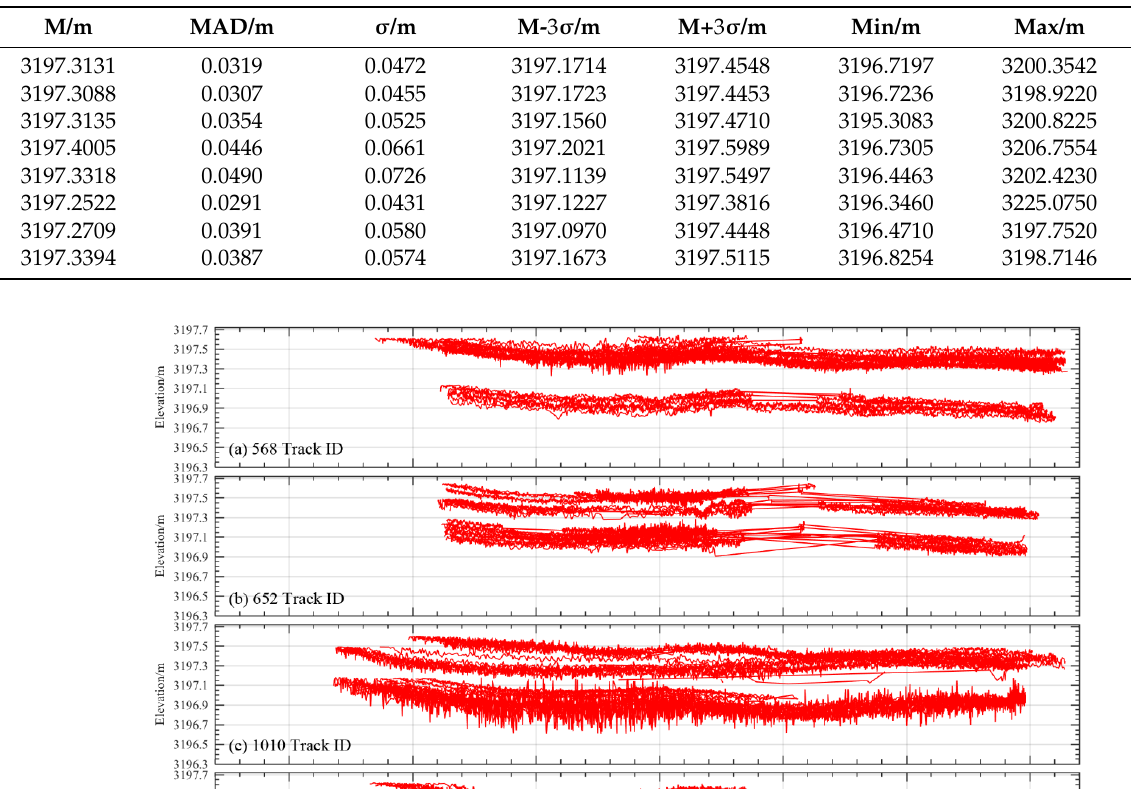
Table 6. The statistical parameters of the MAD outlier method in each combined track.